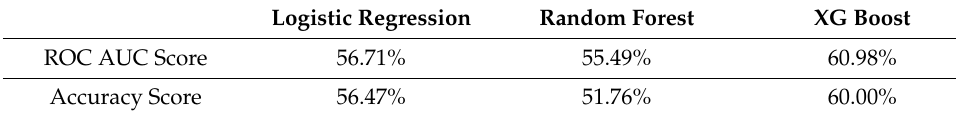
Table 5. Test Score.